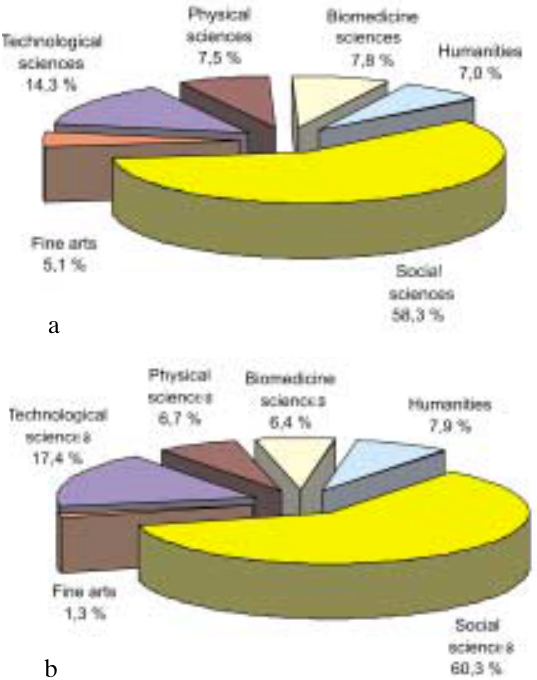
Fig 3. Popularity of courses of studies according to the fields of sciences mentioned in school-leaver’s applications in 2005: a – based on course No 1 in the application;